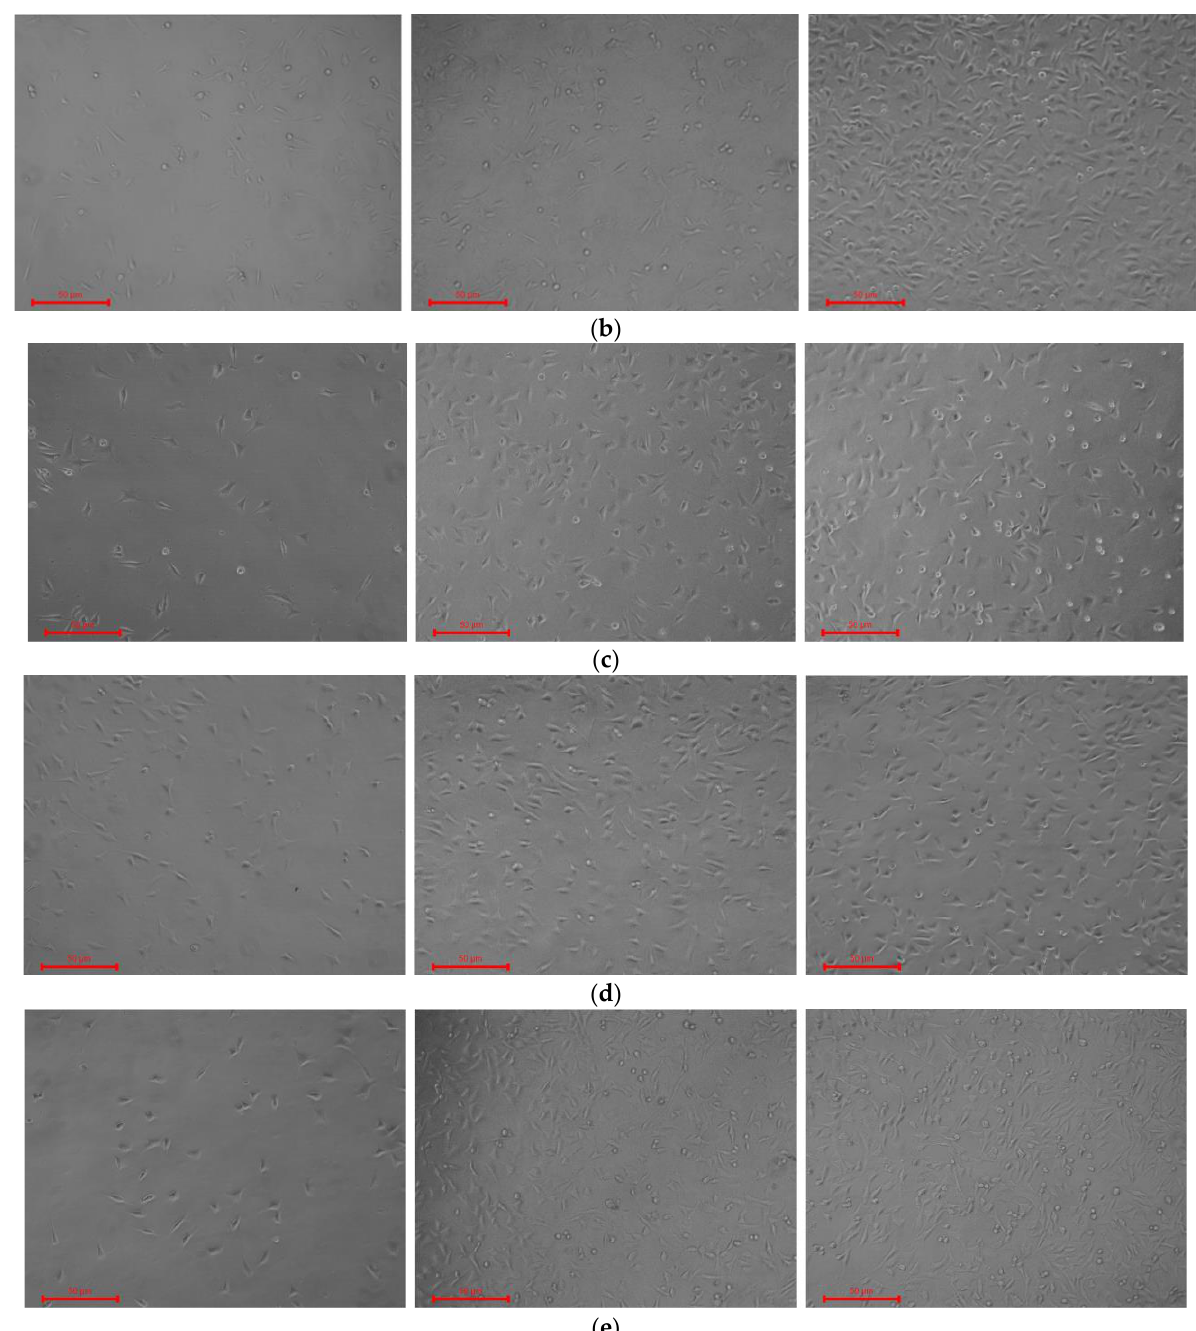
Figure 9. The optical microscopic images of the fibroblasts BJ-5ta after 24, 48 and 72 h (the images aligned left to right respectively) of cultivation in presence of PHB with different content of the hemin: 0% wt. ( b ), 1% wt. ( c ), 3% wt. ( d ), and 5% wt. ( e ); ( a ) control. Bar — 50 µm.